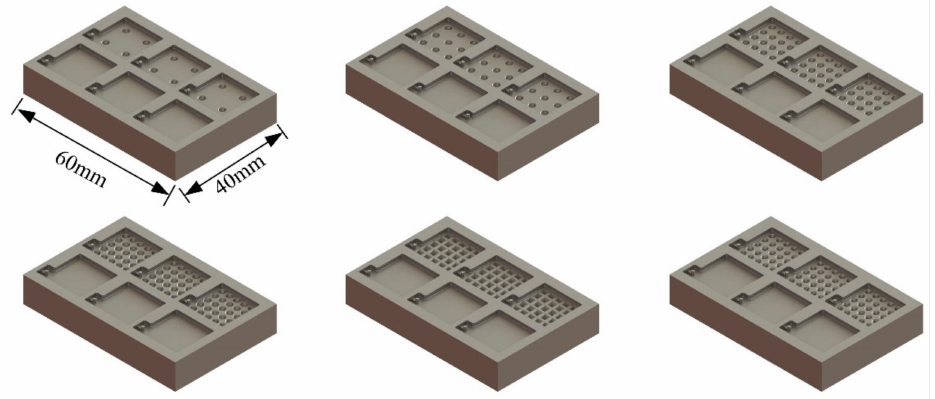
Figure 5. Designed